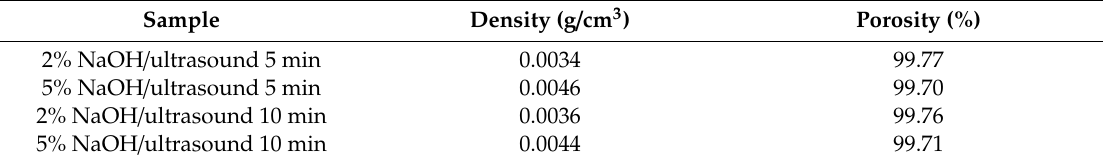
Table 1. Different sol was prepared nanofiber density and porosity of the aerogel.